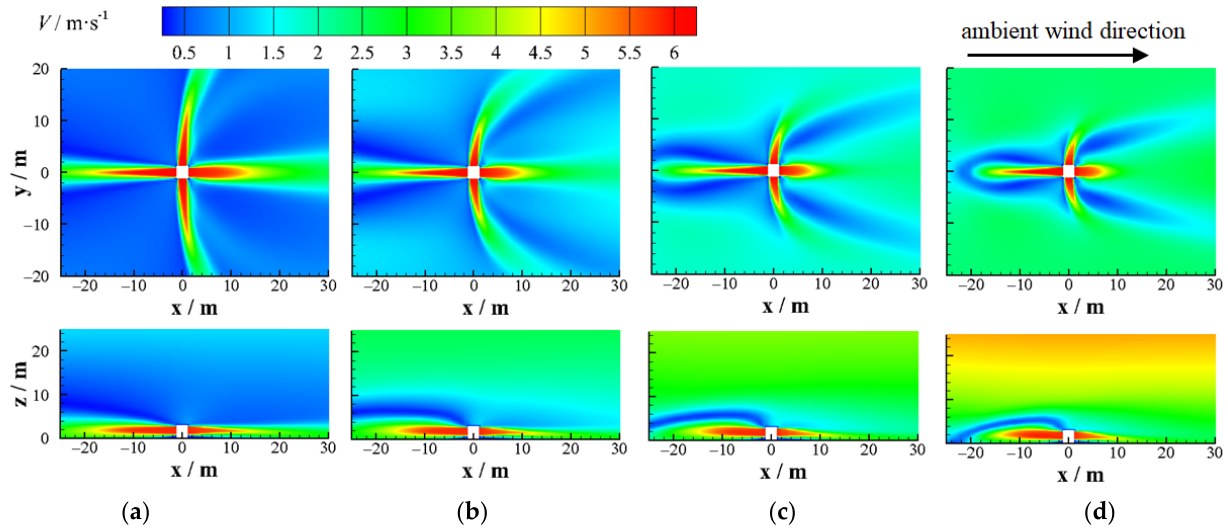
Figure 14. Velocity profiles of the horizontal outlet when V 0 = 6 m/s without considering the ambient wind: ( a ) U = 1 m/s; ( b ) U = 2 m/s; ( c ) U = 3 m/s; ( d ) U = 4 m/s.